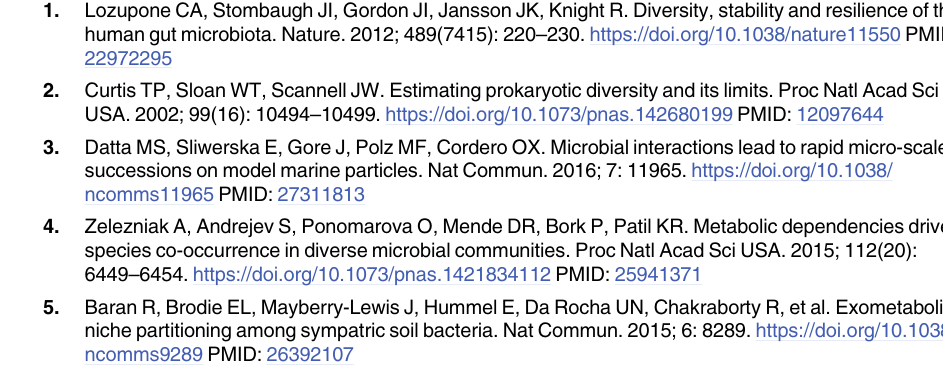
S1 Text. Supplementary information about details of the model of symbiosis among ran- domly generated